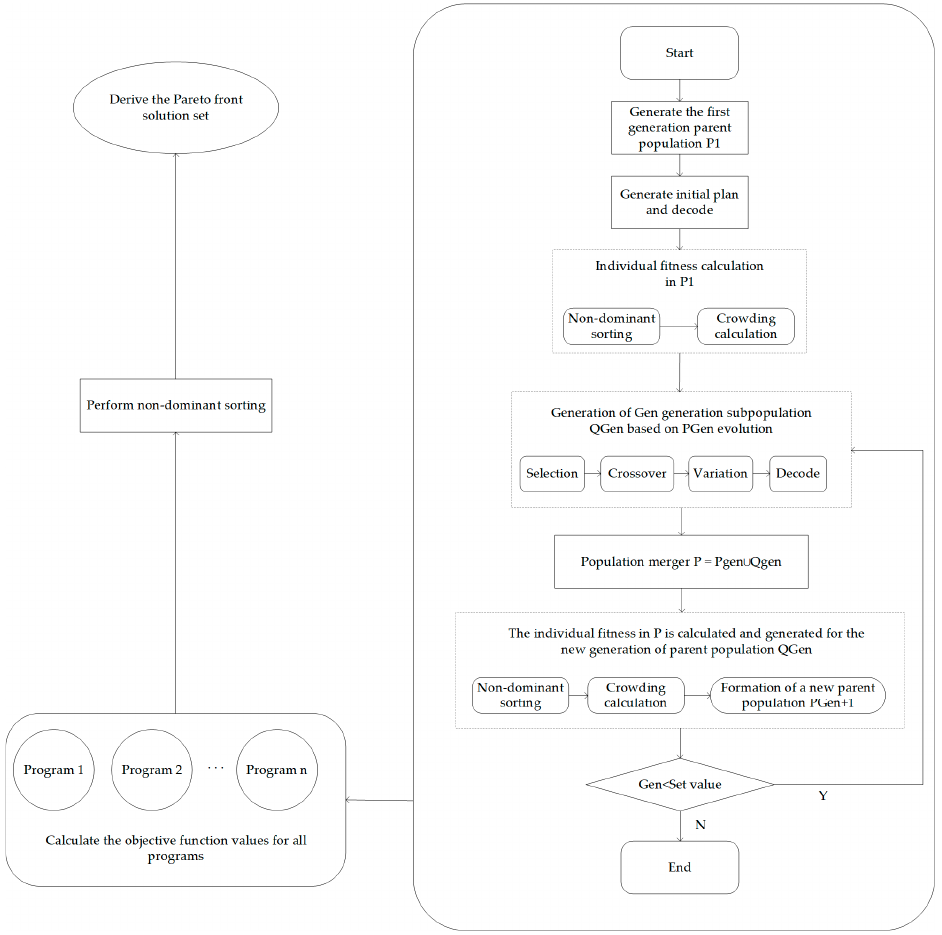
Figure 2. Algorithm flowchart.